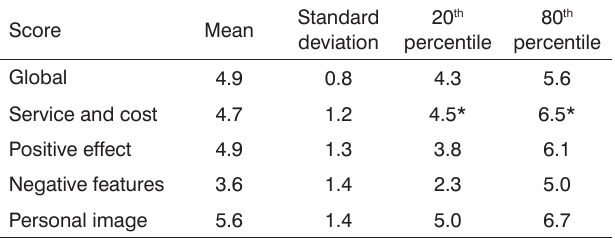
Table 1. Mean global and subscale scores and their respective standard deviations for the 20 th and 80 th percentiles of the SADL scale according to the paper published by Cox and Alexander (1999) 6 .